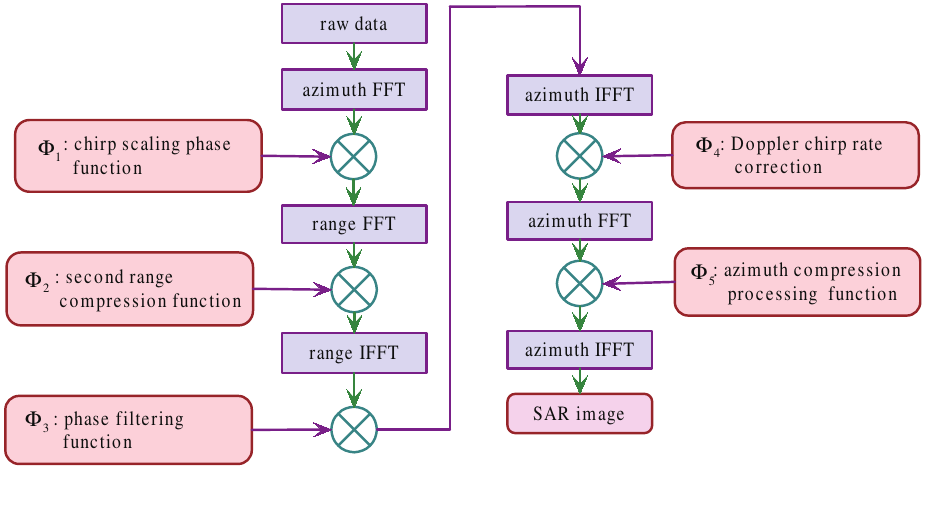
Table 2. The PRF parameters used in the simulation.